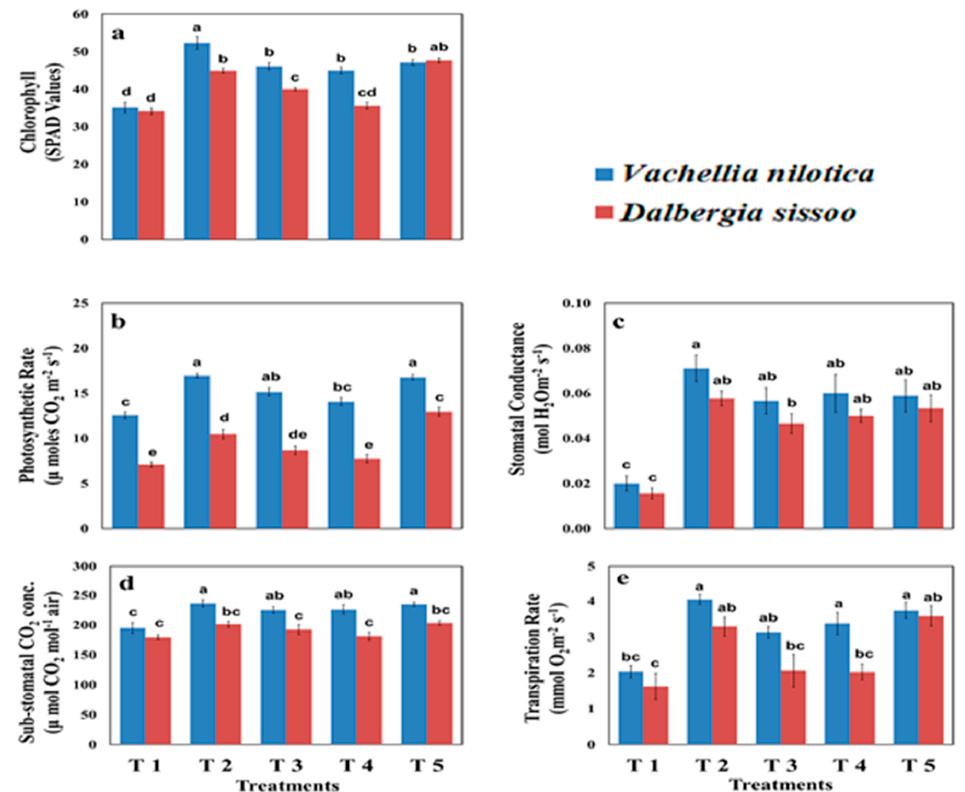
Figure 2. Effect of different organic amendments on ( a ) chlorophyll content, ( b ) photosynthetic rate, ( c ) stomatal conductance, ( d ) substomatal CO 2 concentration, ( e ) transpiration rate of Vachellia nilotica and Dalbergia sissoo , where T1 = control, T2 = farmyard manure, T3 = poultry manure, T4 = slurry, T5 = biochar. The lower case letters indicate that values are significantly ( p < 0.05) different from each other.